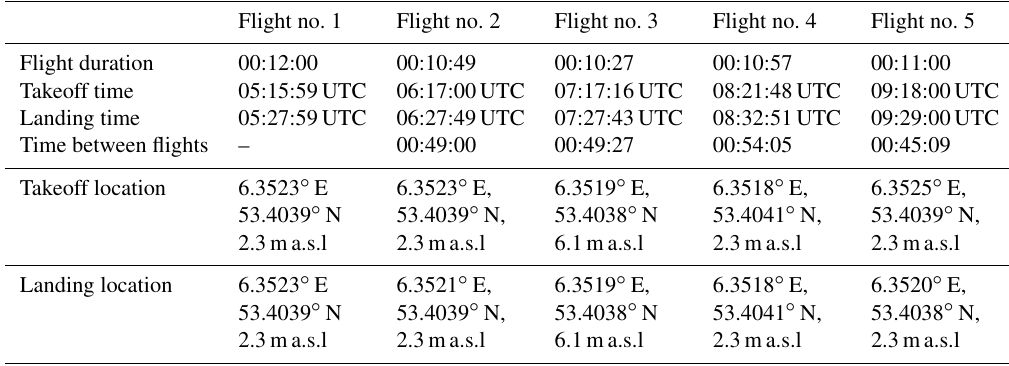
Table 3. Some of the common characteristics for the five different flights. Flight no. 1 Flight no. 2